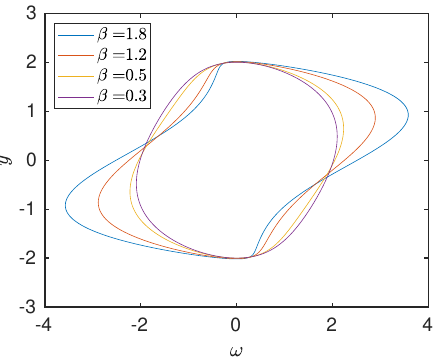
Figure 9. Attractor of the state vector of Equation (34), for different values of β . Here, T = 100.